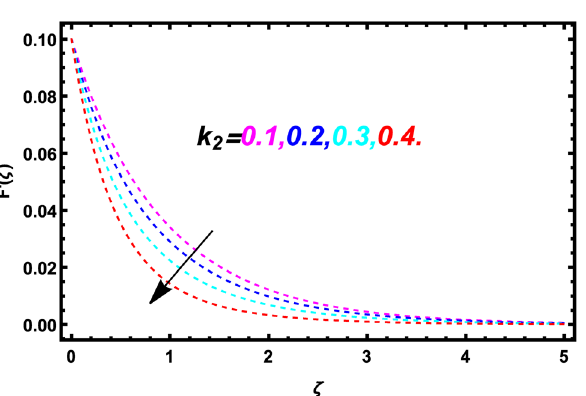
Figure 6. Demonstration of velocity curve versus k 2 when Fr = 0.2, k 1 = 0.1, M = 0.5, m = 0.2, Pr = 5.3, φ = 0.01, Ec = 0.3, ε Rd = 0.2, Sc = 0.1, ε Lb = 0.3, Pe = 0.3. t = 3.0, C = 3.0, δ = 0.3,